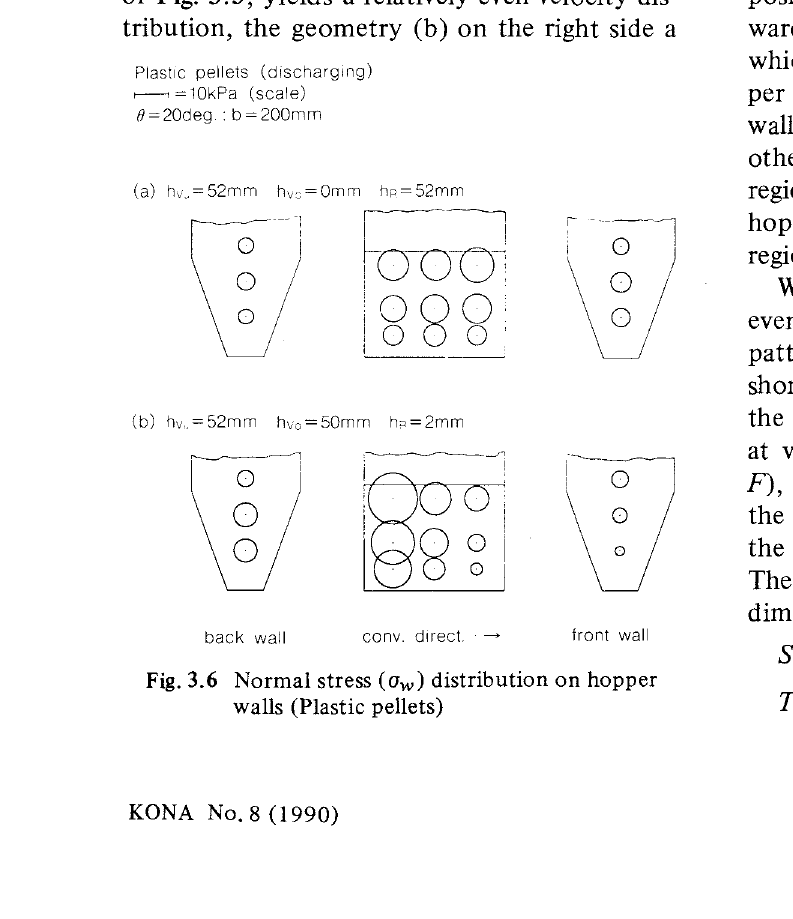
Fig. 3.6 Normal stress (aw) distribution on hopper walls (Plastic